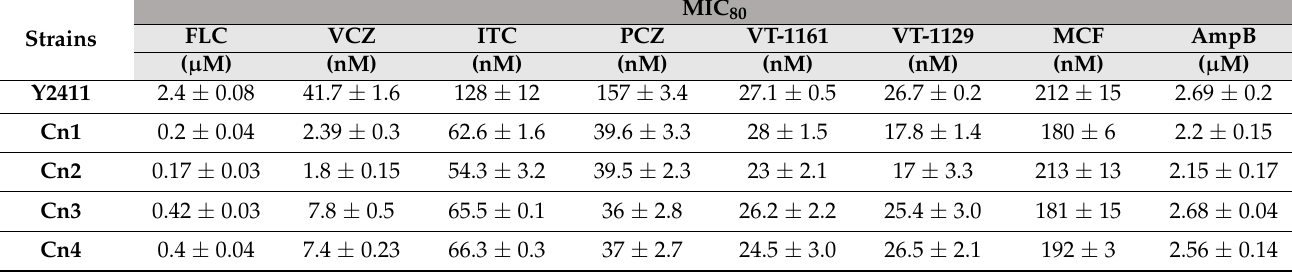
Table 2. MIC 80 values for strains overexpressing CnCYP51 with/without CnCPR .